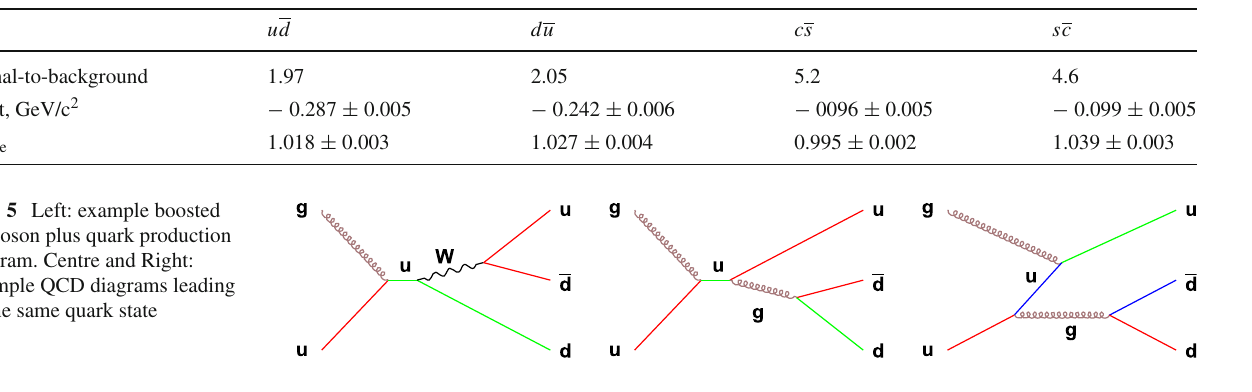
Table 3 Interference effects on the qq → W peak by final state quark flavour. Signal-to-background is defined at the resonance peak without experimental resolution and using only the initial and final states quoted, with negligible statistical error